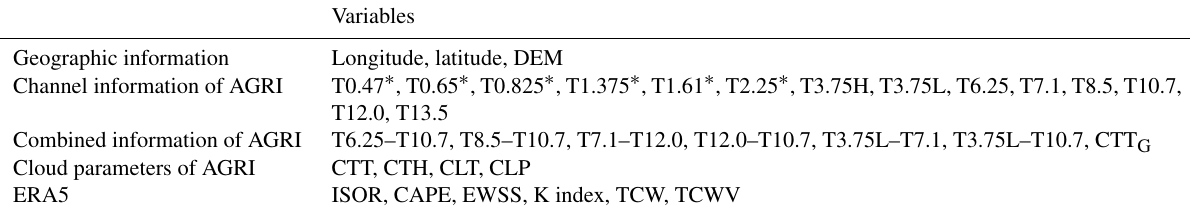
Table 1. Variables used in the QPE algorithm.